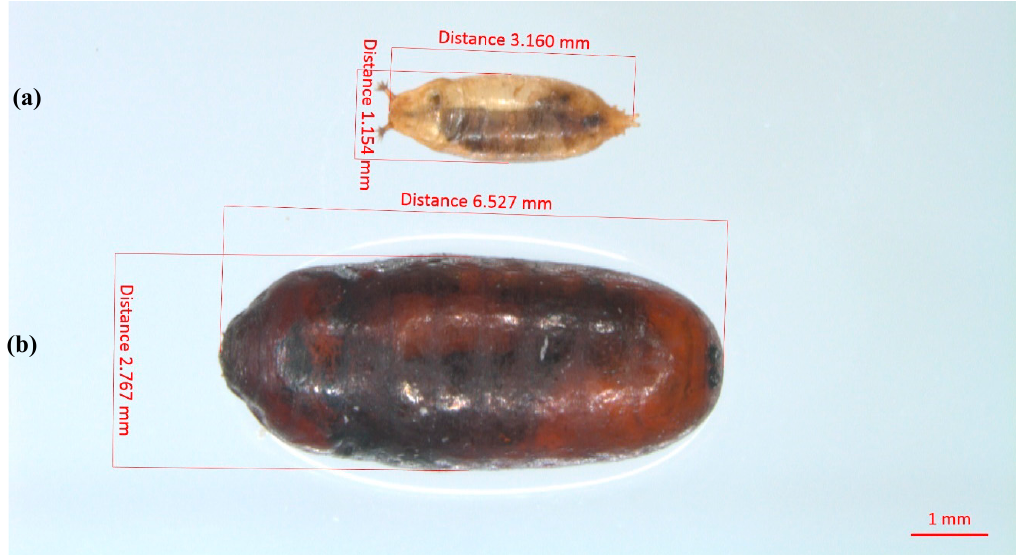
Figure 5. Size differences between host D. suzukii and M. domestica pupae. ( a ) parasitized D. suzukii pupa; ( b ) parasitized M. domestica pupa.